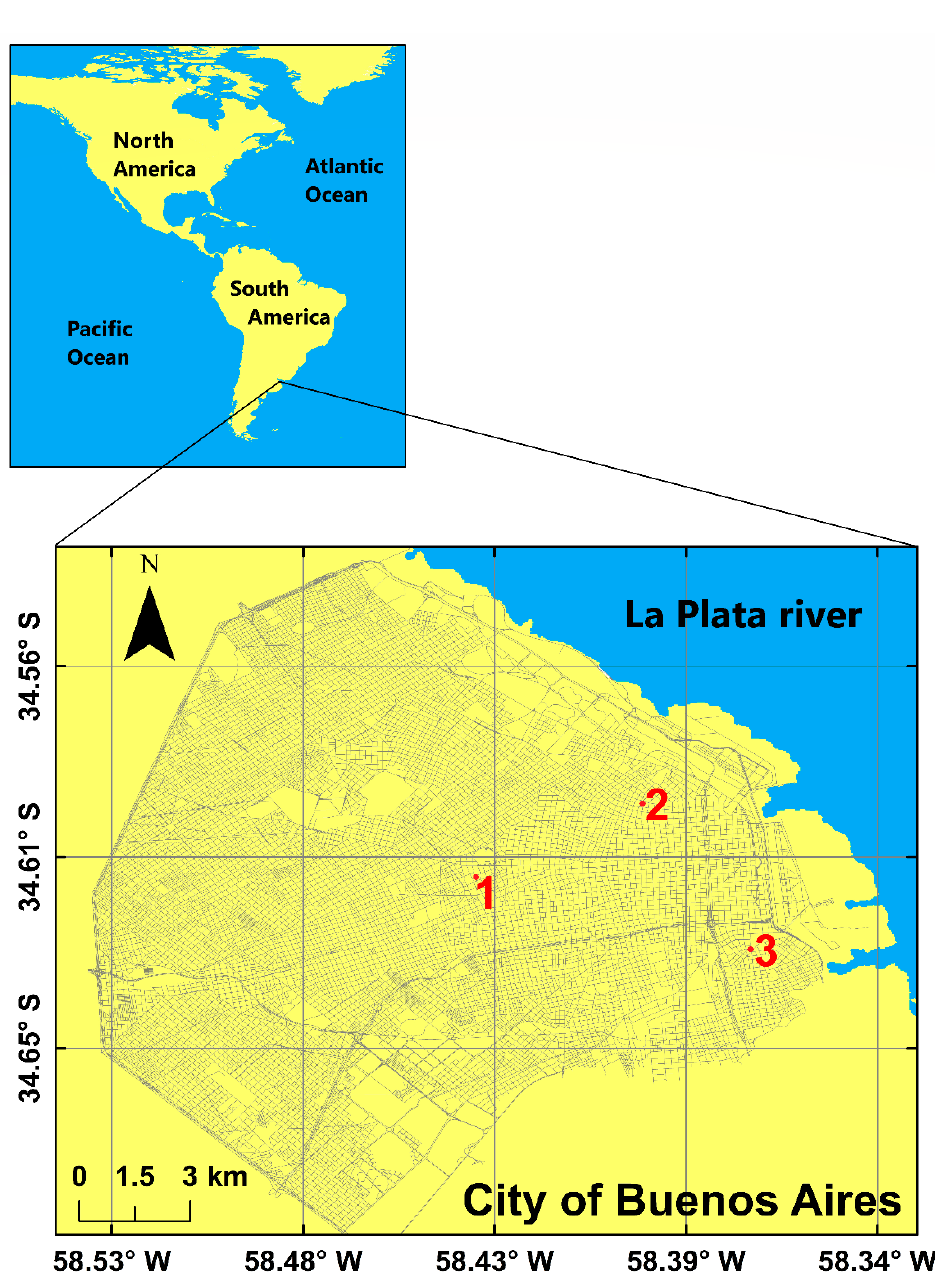
Figure 1. Location of CABA on the American continent and its air quality monitoring stations. Numbers indicate the locations of the monitoring stations: ( 1 ) Centenario; ( 2 ) La Boca and, ( 3 ) Cordoba.